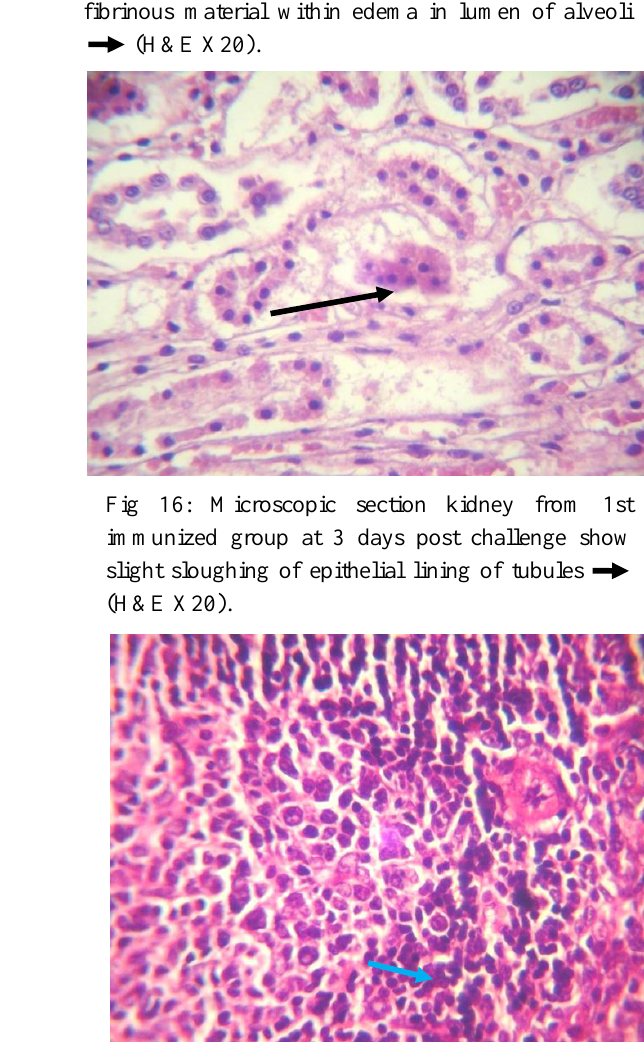
Fig 17: Microscopic section of spleen from 2nd immunized group at 3 days post challenge show slight congestion of red pulp with slight depletion of white pulp (H&E X20).